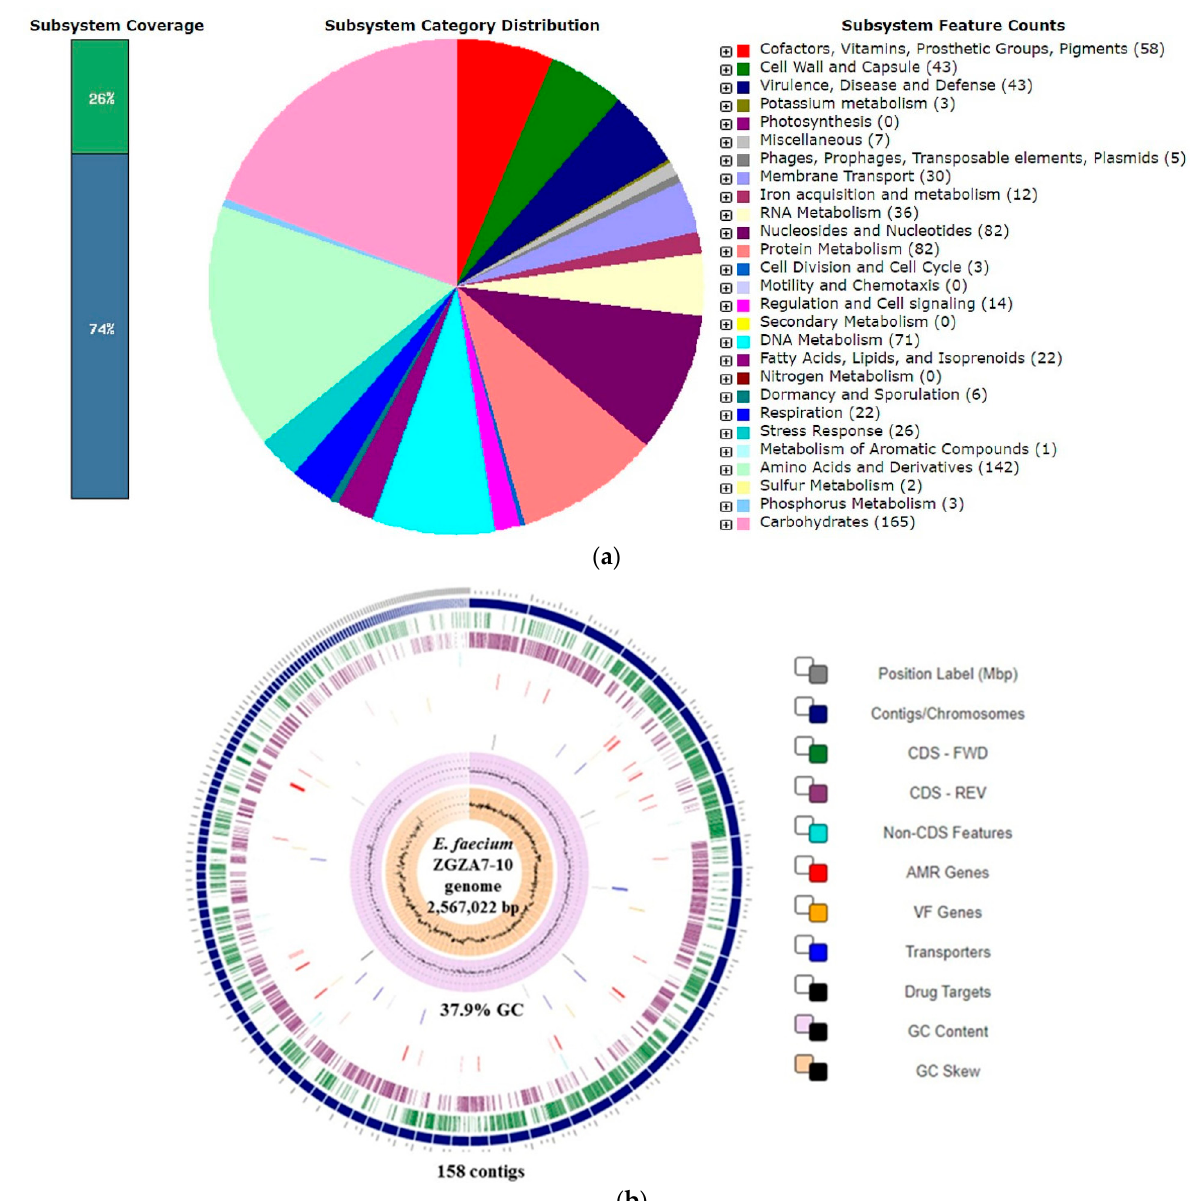
Figure 1. Functional annotation of E. faecium ZGZA7-10: ( a ) by RAST; ( b ) circular genome map generated with PATRIC. From outer to inner rings are contigs, coding sequence (CDS) on the forward strand, CDS on the reverse strand, RNA genes, CDS with homology to known antimicrobial resistance genes, CDS with homology to known transporters, CDS with homology to known drug targets, GC content, and GC skew.